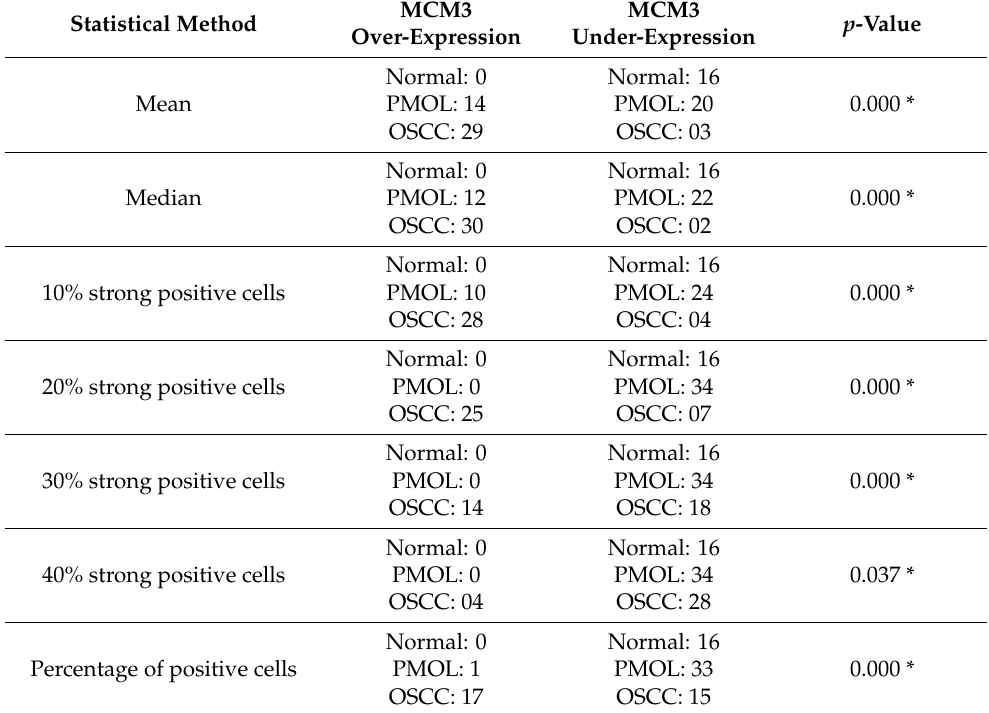
Table 4. Differential MCM3 expression and oral lesions.